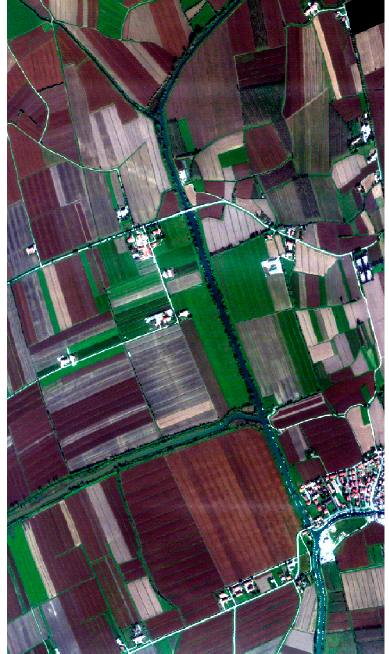
Figure 3. A sample of RGB (11-7-2) MIVIS imagery depicting the area N of Aquileia. Strong geometric distortions can be clearly identified along the left edge of the image.